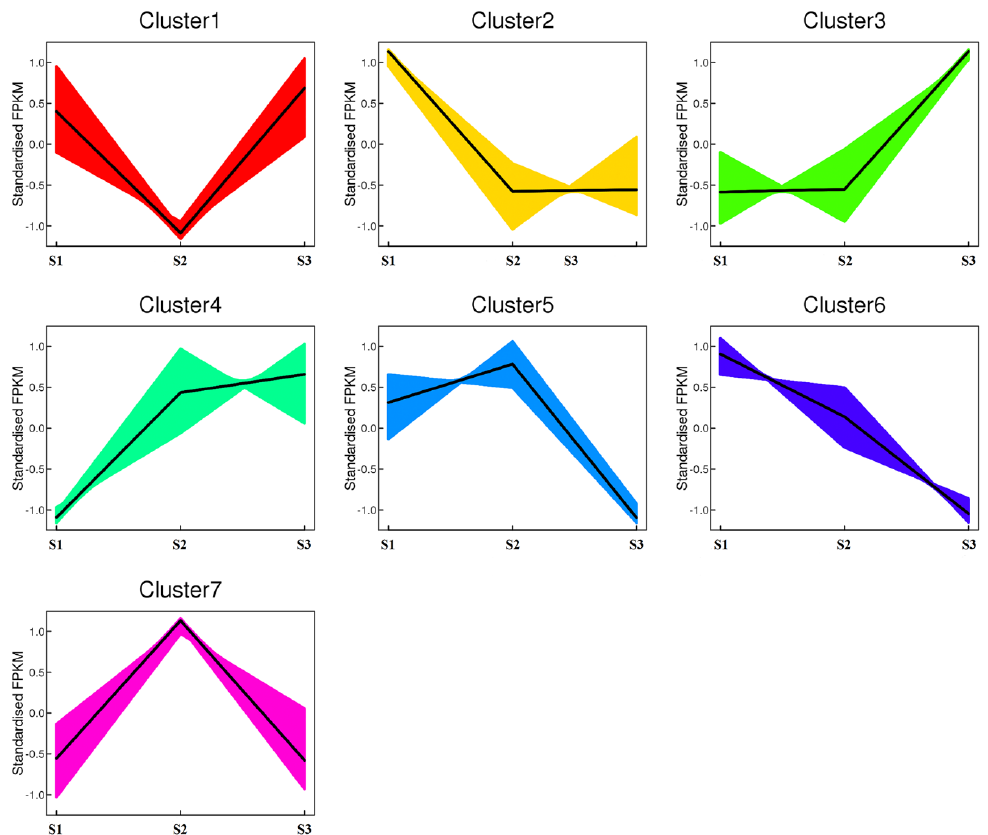
Figure 1. Clustered gene expression profiles from developing tartary buckwheat seeds. The clusters were defined on the basis of genes’ temporal expression profiles in R using K-means. The Y-axis represents the standardized FPKM value of genes, and the X-axis represents the di ff erent sample. S1, S2, and S3 stand for the seed samples at pre-filling stage, filling stage, and initial maturity stage,